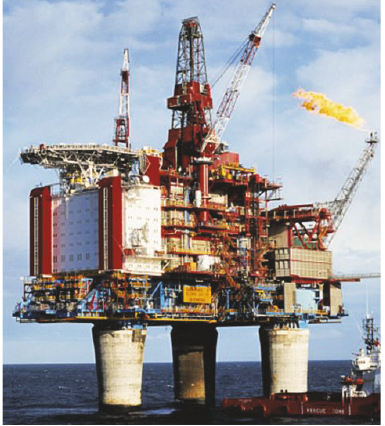
Figure 1: Offshore platforms pillar groups.